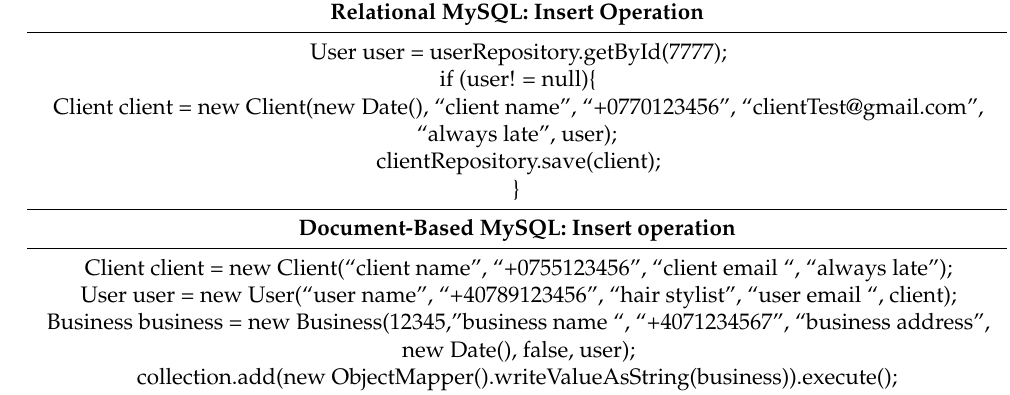
Table 3. Insert operation. Relational MySQL: Insert Operation